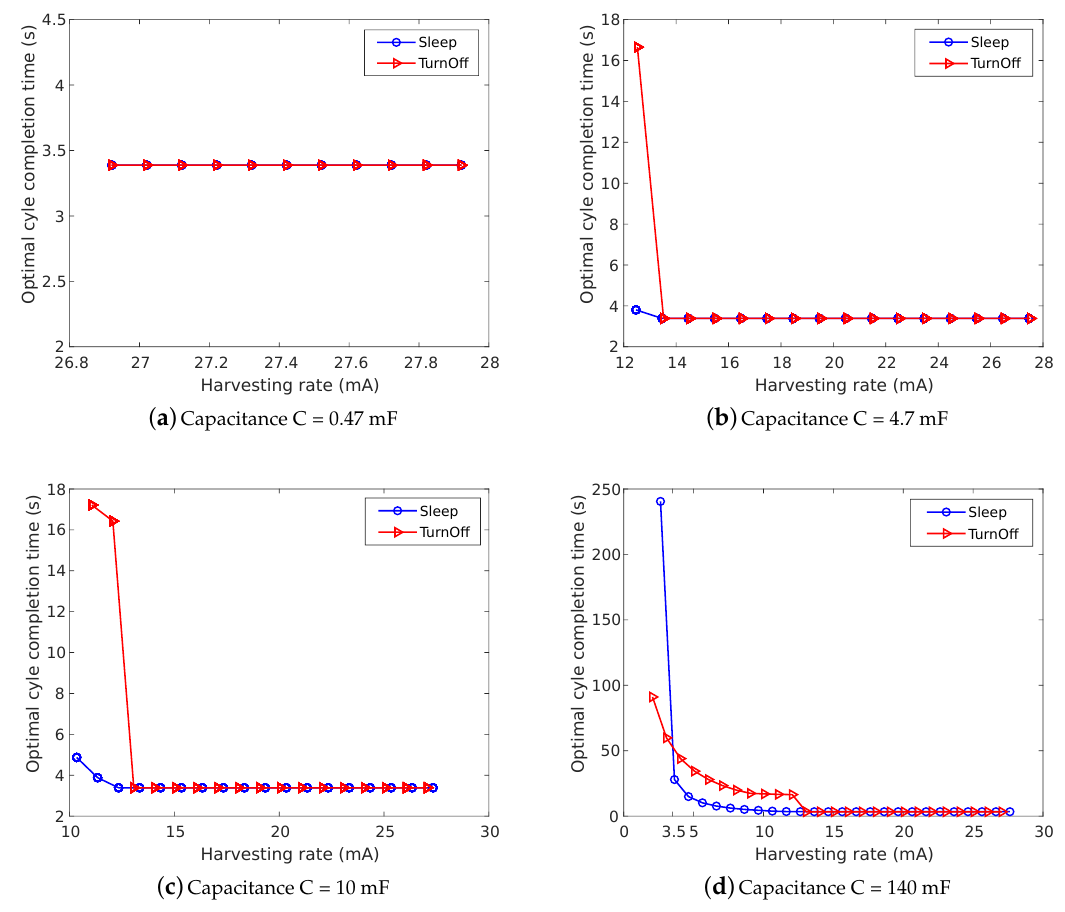
Figure 11. Optimal cycle completion time for different capacitance including all considered